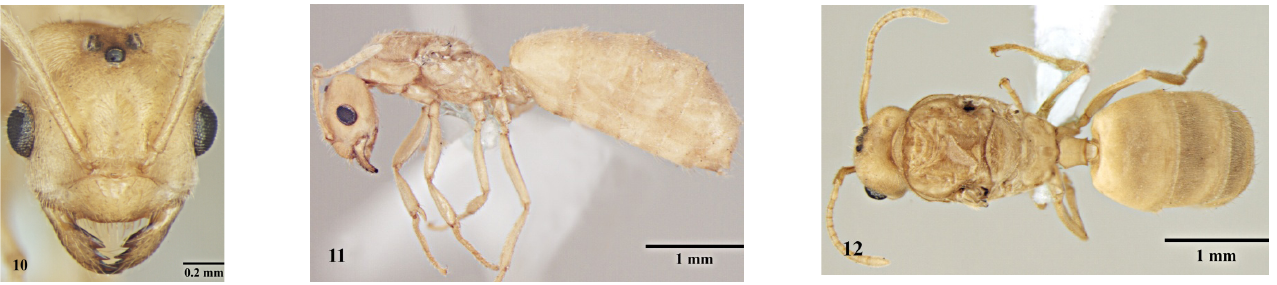
Fig. 10-12. Pseudolasius diversus sp. n ., gyne 10) head, full face view; 11) body, lateral view; 12) body, dorsal